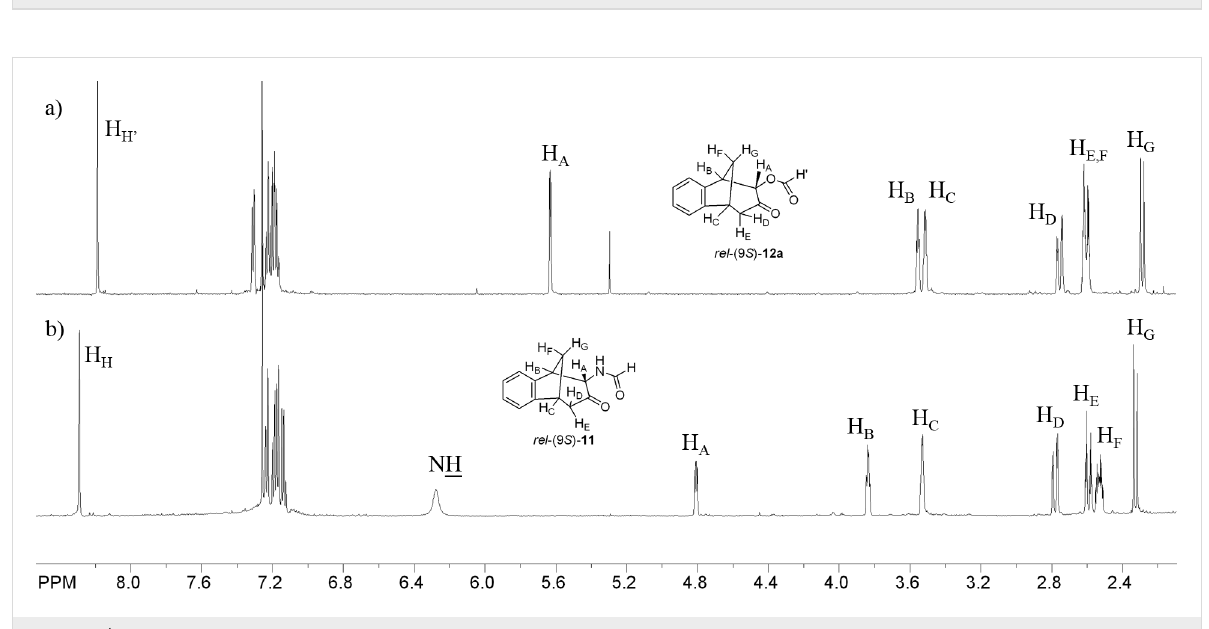
Scheme 3: Plausible mechanisms of oxazoline ring-opening in photoproduct 10 .